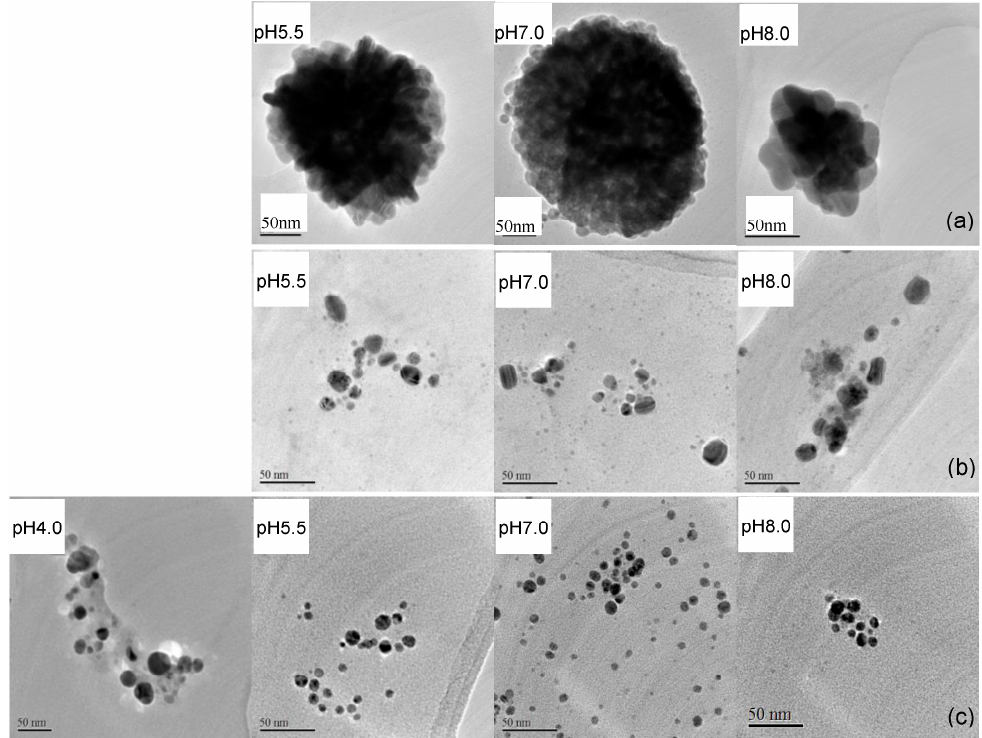
Figure 2. Transmission electron microscopy of ( a ) P 0.5 -AgNPs; ( b ) P 2.0 -AgNPs; and ( c ) P 5.0 -AgNPs at different pH. (AgNP formation did not occur at pH = 4 for EPS fractions P 0.5 and P 2.0 ).